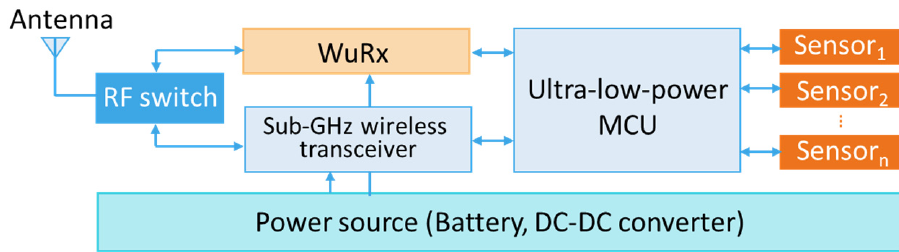
Figure 8. Block diagram of a typical wireless sensor node with a WuRx.